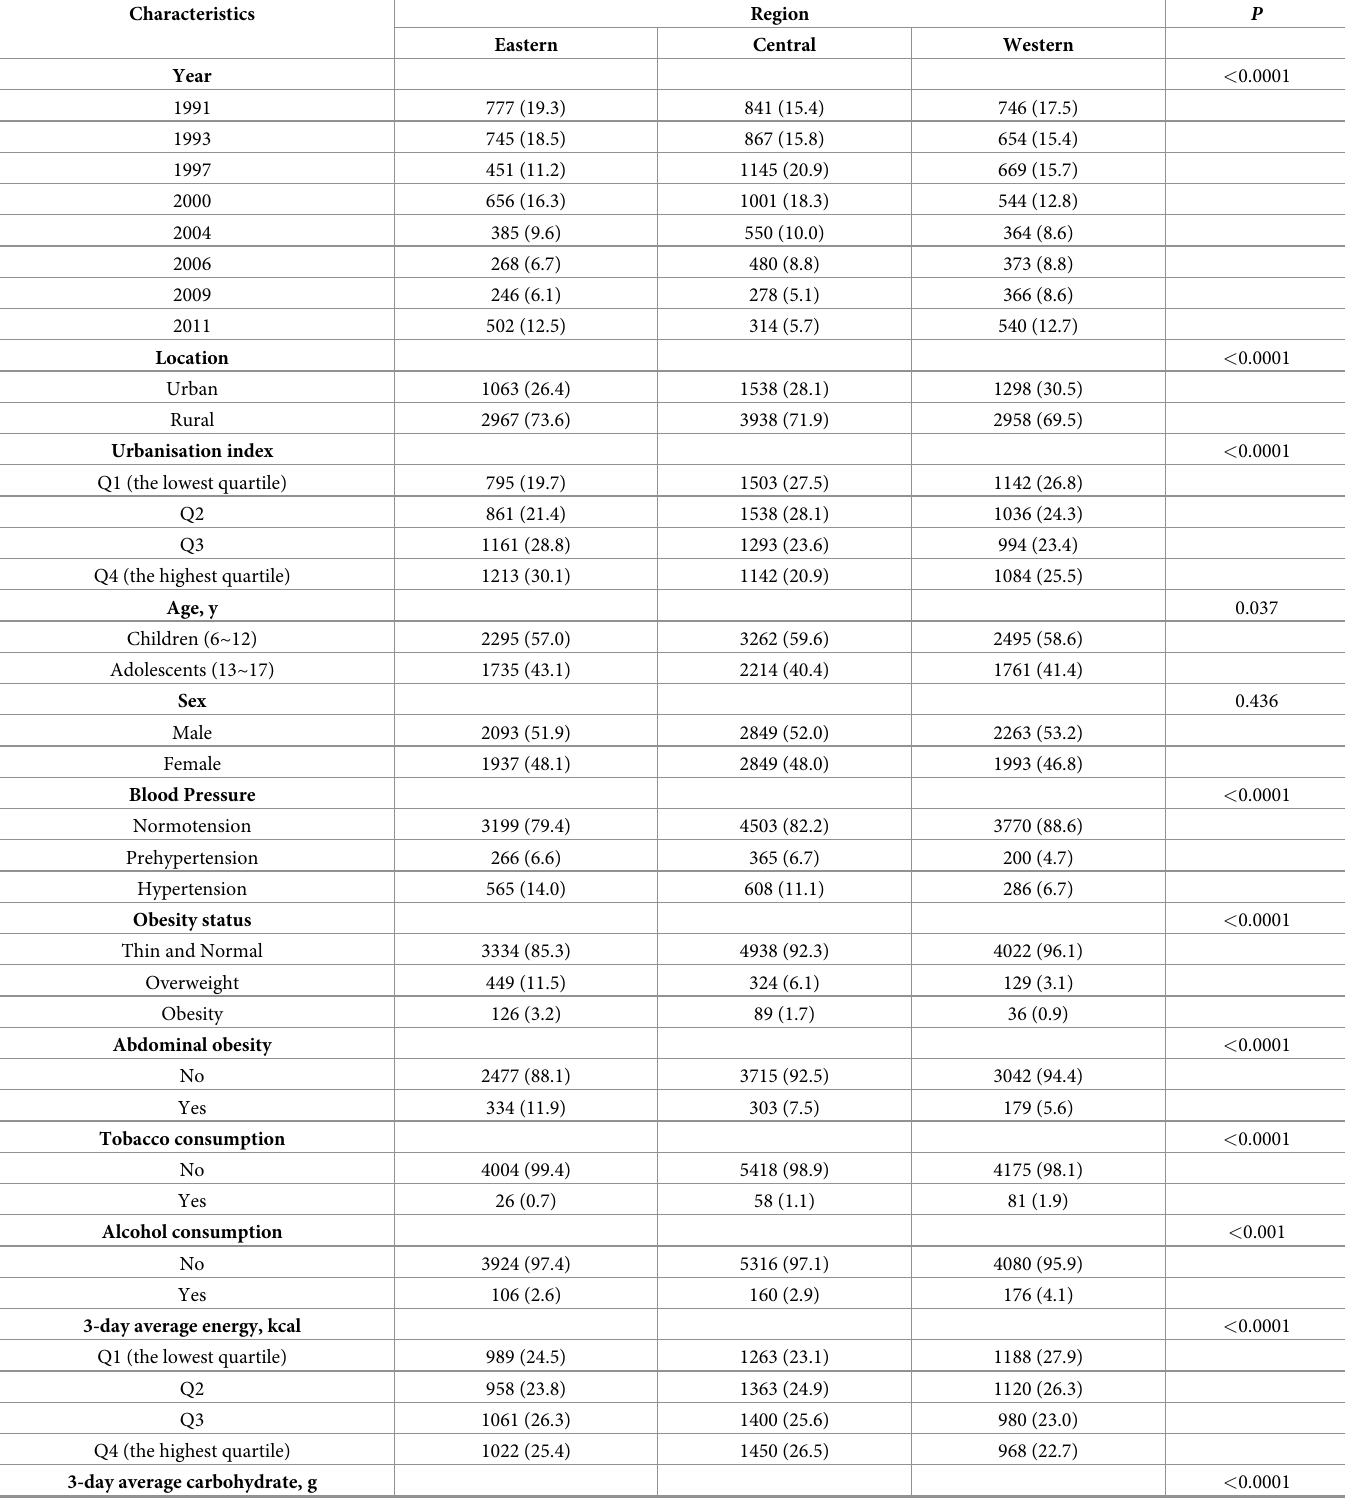
Table 1. Characteristics of participants stratified by region.